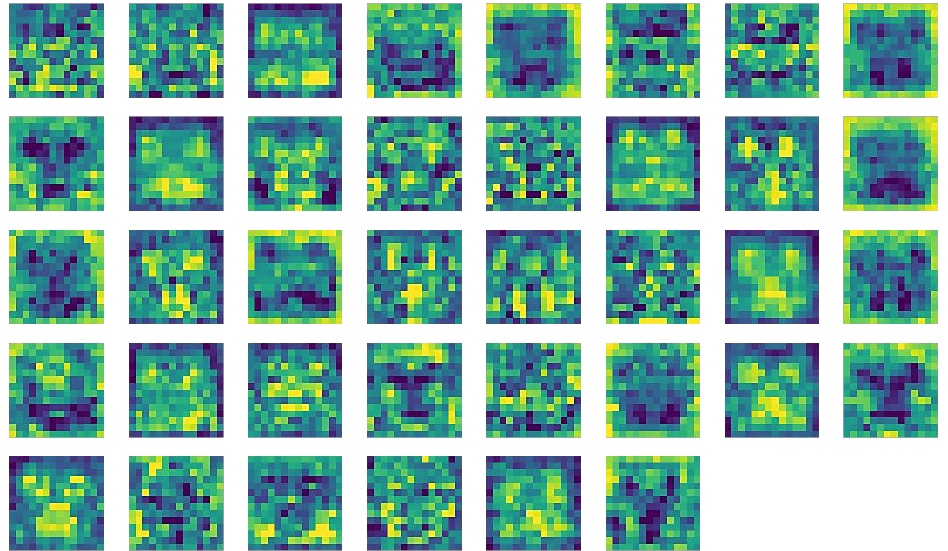
Figure 6. Output feature map of Efficient-ME. The feature maps shown are a sample of 37 features from the total 112 features.